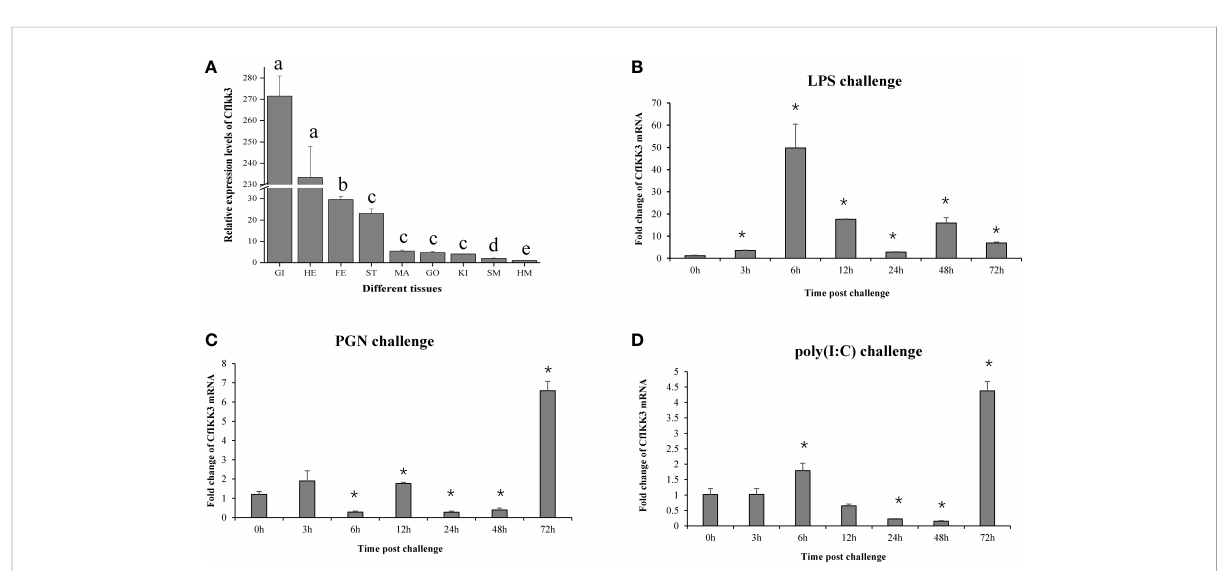
FIGURE 4 Expression pro fi les of CfIKK3 mRNA in different tissues (A) and after LPS, PGN, and poly(I:C) challenges (B – D) , as determined using qRT-PCR. The EF-1 a gene was chosen as the internal control gene, and hemocytes were used as a reference sample. The tissue-speci fi c expression data were statistically analyzed with one-way ANOVA. For PAMP challenge assays, sampling was conducted at 0, 3, 6, 12, 24, 48, and 72 h after challenge. EF-1 a gene was employed as the internal control, and time 0 h was considered as the reference sample. Vertical bars represent the mean ± SD (N = 3). * p < 0.05, according to the unpaired two-tailed t -test. GI, gill; HE, hepatopancreas; FE, feet; ST, striated muscle; MA, mantle; GO, gonad; KI, kidney; SM, smooth muscle; HM, hemocytes. LPS, lipopolysaccharide; PGN, peptidoglycan; poly(I:C), polyinosinic – polycytidylic